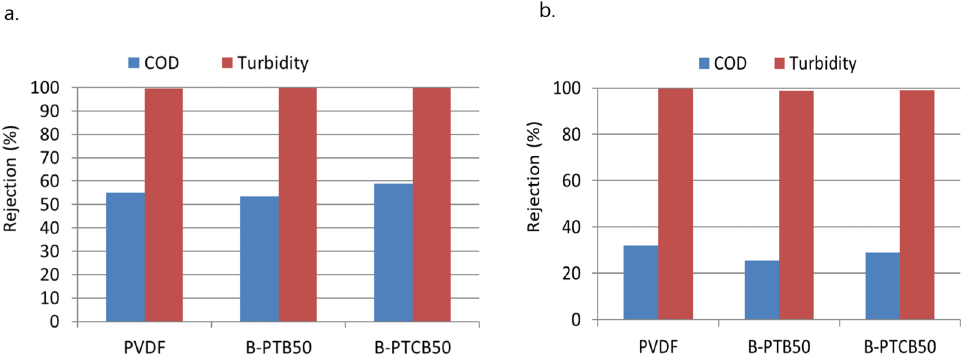
Figure 6. Rejection performance of pristine PVDF, PTB50, and PTCB50 membranes during real dairy wastewater filtration, using unfiltered ( a ) or pre-filtered (0.2 µ m filter paper) wastewater ( b ).